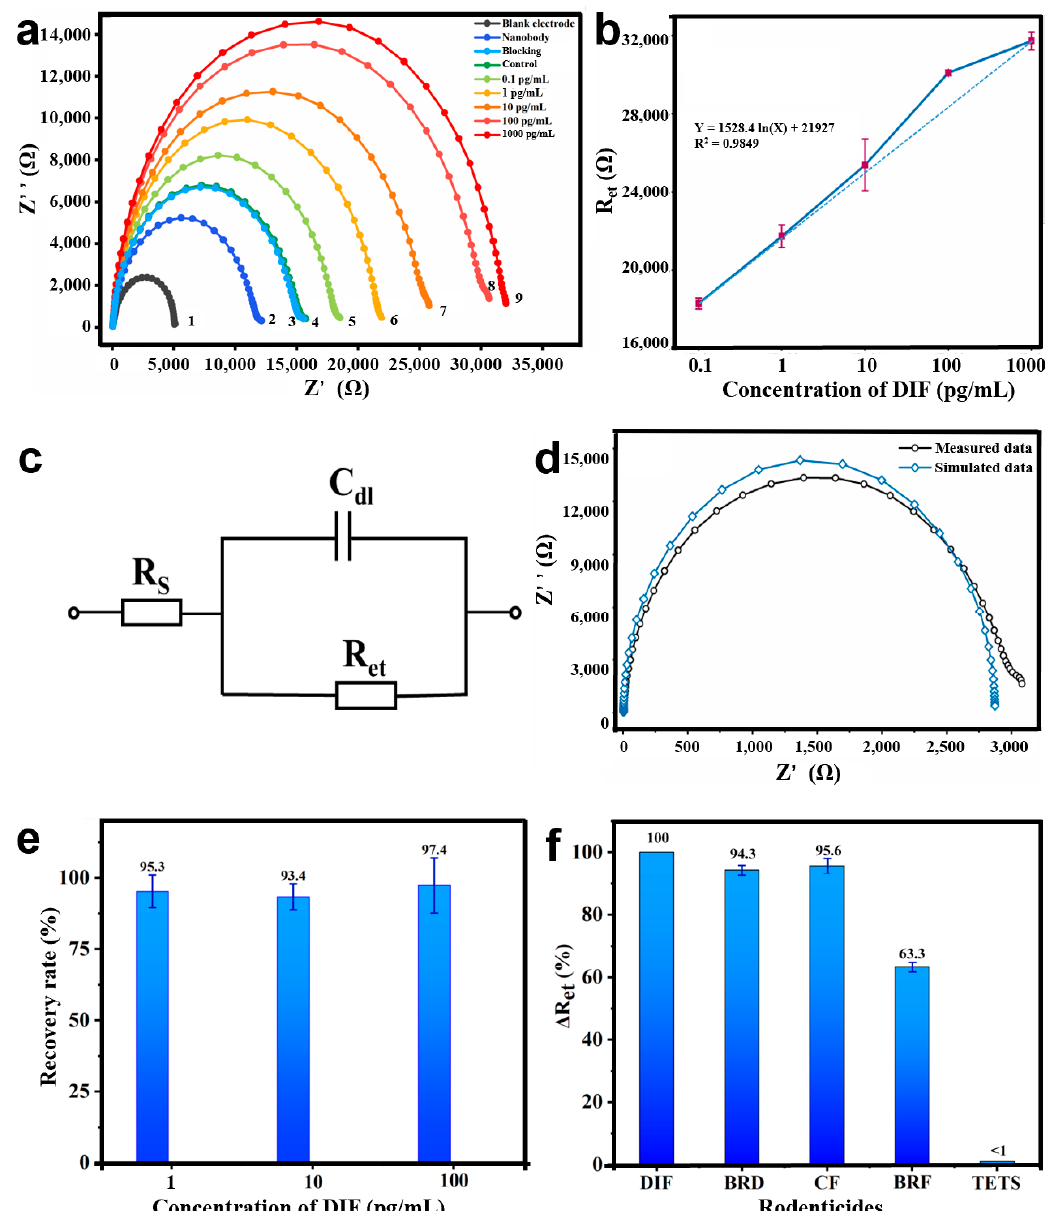
Figure 7. ( a ) The bioimpedance sensor fabrication process and Nyquist diagram for determining of DIF with different concentrations ( N = 3). Assembling and detection steps of the bioimpedance sensor: Electrochemical impedance spectroscopy (EIS) in 2.0 mM [Fe(CN)6] 3 − /4 − for (1) bare gold electrode, (2) AR-H2-1, (3) calf serum blocking, (4) control. As the DIF concentration increased, more of the DIF was captured by the AR-H2-1 on the surface of the polycrystalline gold film, where the diameter of the Nyquist circle added (5)–(9). ( b ) Linear relationship curve between different DIF concentrations and R et . ( c ) The equivalent circuit model used to simulate the working situation of the novel bioimpedance sensor. ( d ) Nyquist plot was demonstrated both in software simulation data (blue line) and actual measurement data (black line) impedance spectra. ( e ) The recoveries of DIF were from 93.4% to 97.4% in serum samples when 1, 10, 100 pg/mL of DIF were added. ( f ) Cross reaction was gained utilizing a series of rodenticides (DIF, BRD, CF, BFR, TETS) at a concentration of 100 pg/mL.